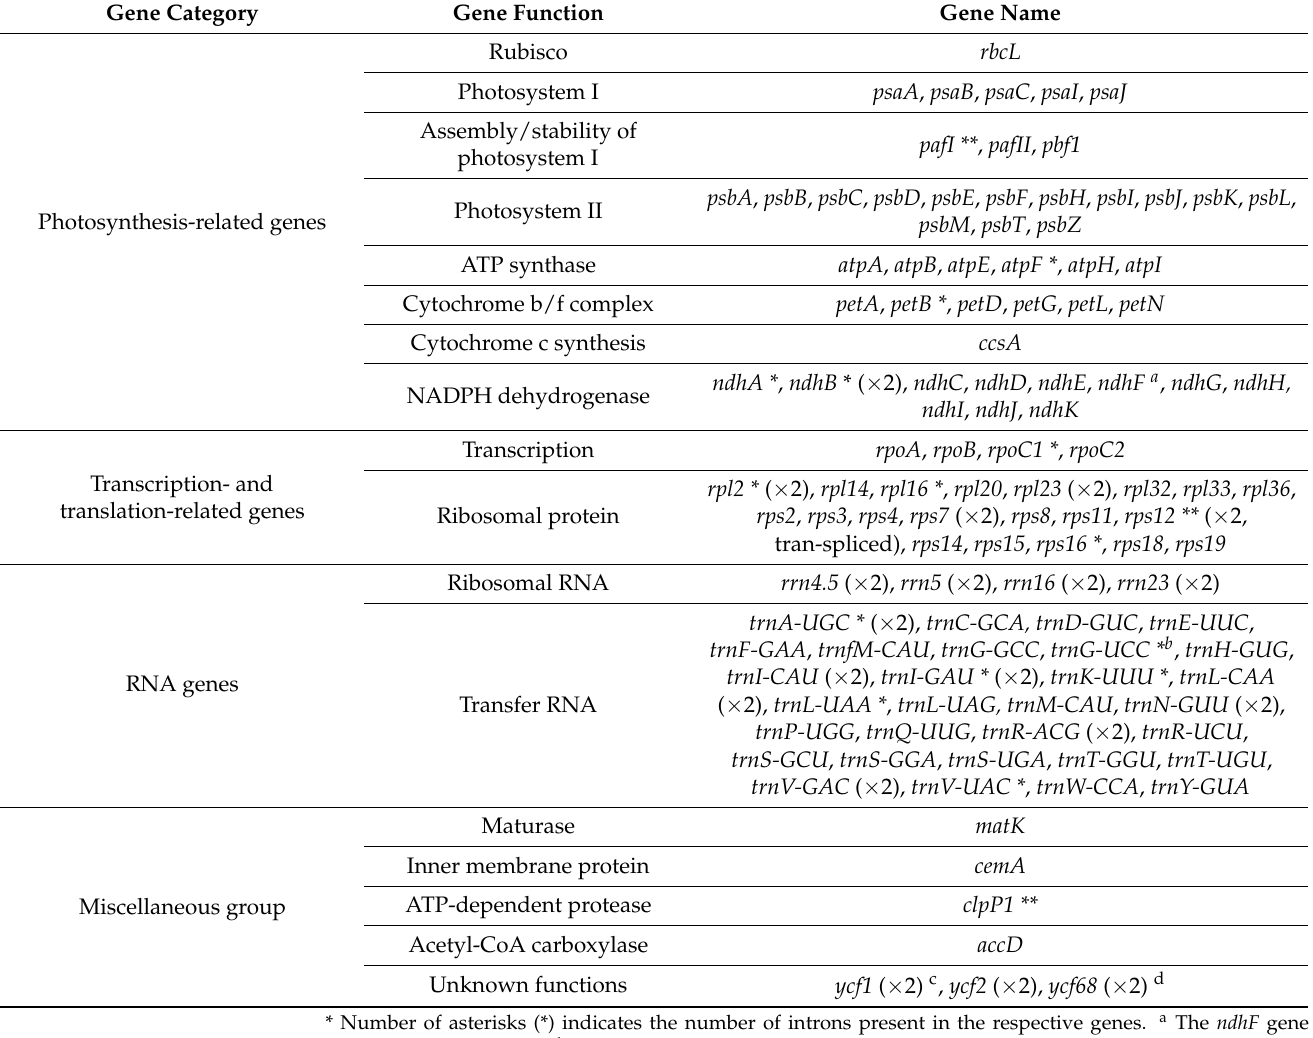
Table 2. Genes annotated in the five Dalbergia chloroplast